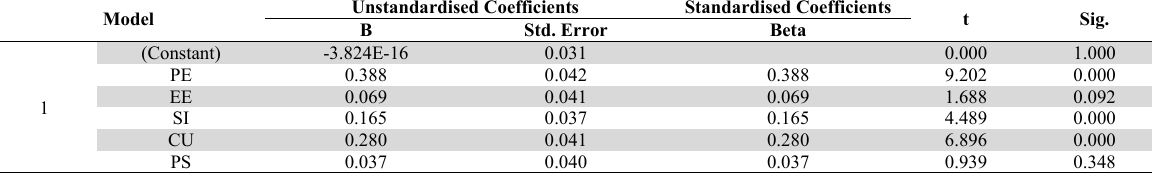
Multiple Linear Regression Analysis: Regression Coefficient T-sig Test Result